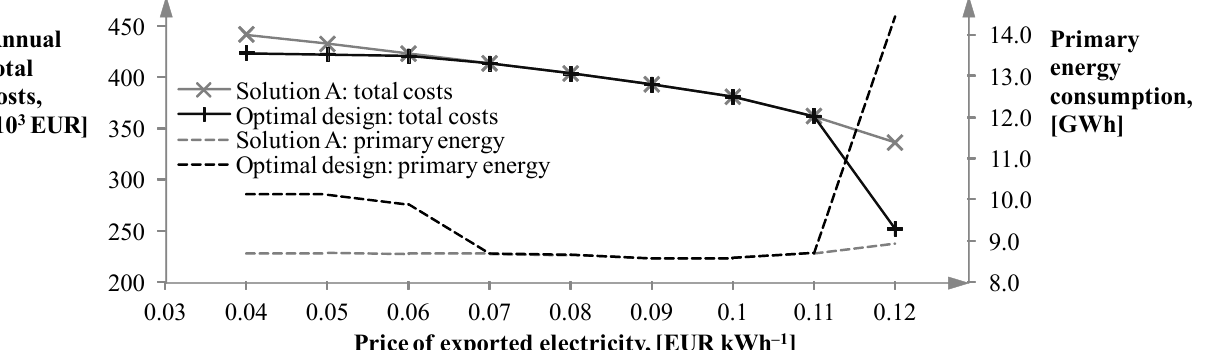
Figure 5. Annual total costs and primary energy consumption as functions of the price of exported electricity.